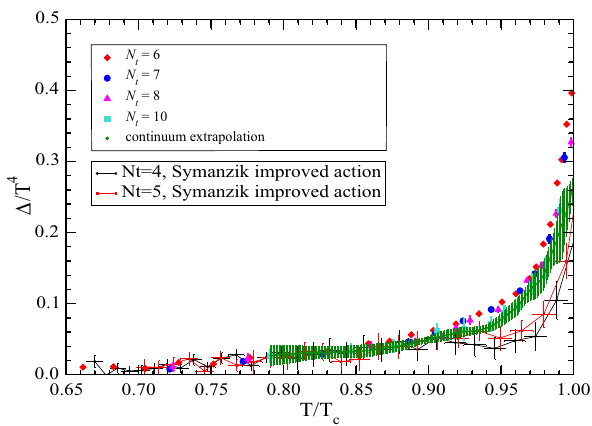
Fig. 20 Comparison of the trace anomaly in the confined phase, mea- sured in this work, with data taken from Ref. [52]